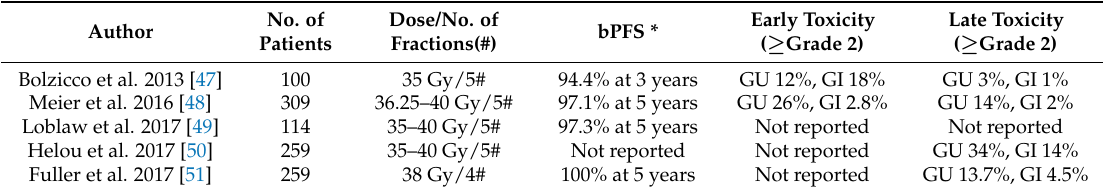
Table 2. Prostate SBRT prospective